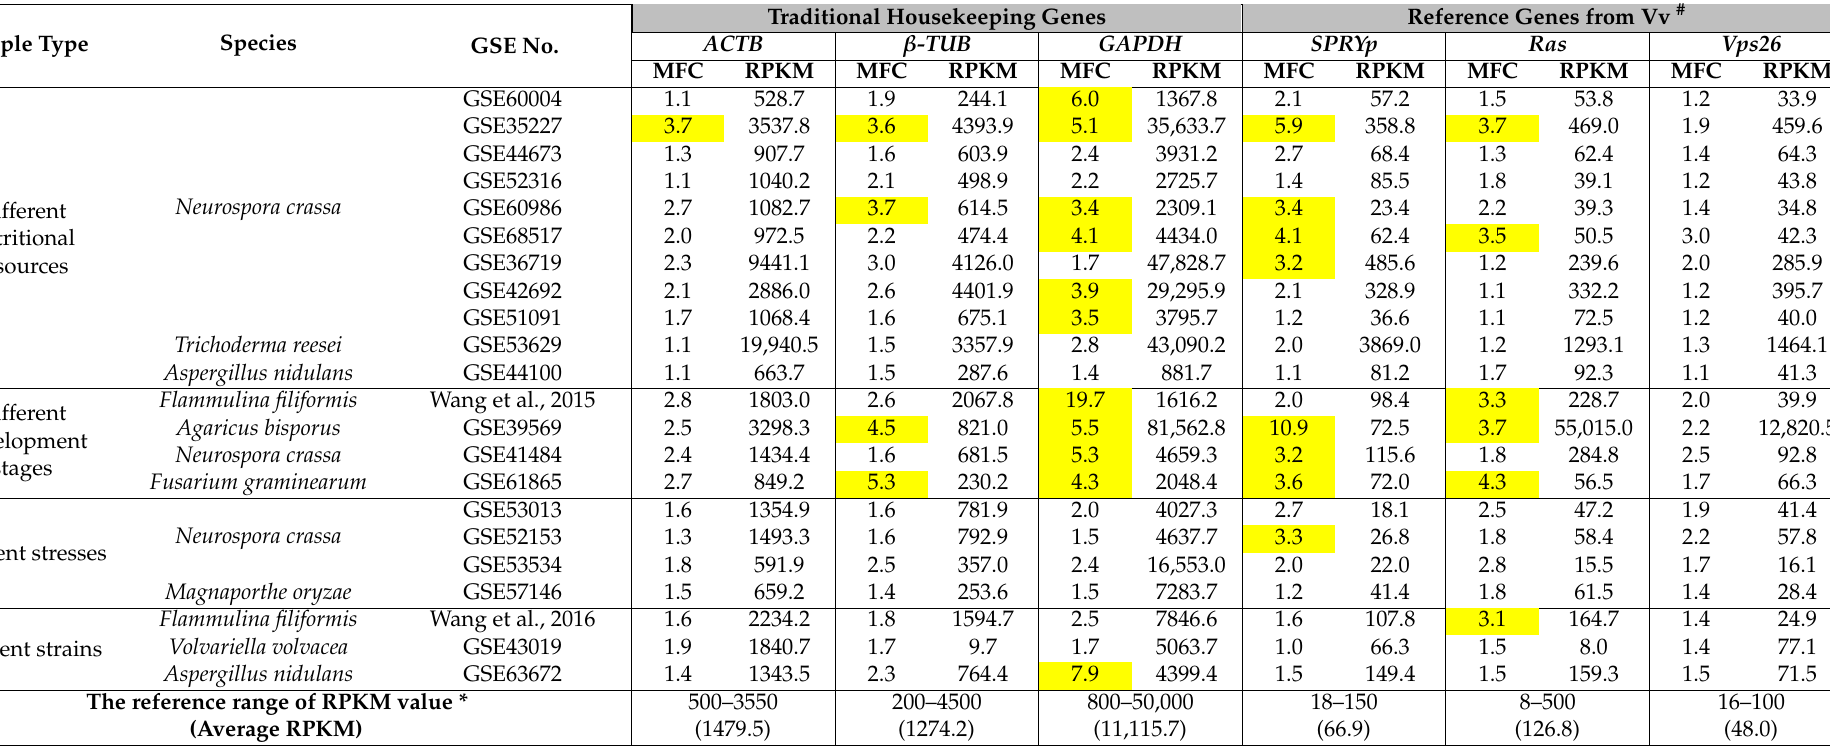
Table 1. The maximum fold change (MFC) and the average expression levels (RPKM) of the traditional housekeeping genes and reference genes identified from Volvariella volvacea #